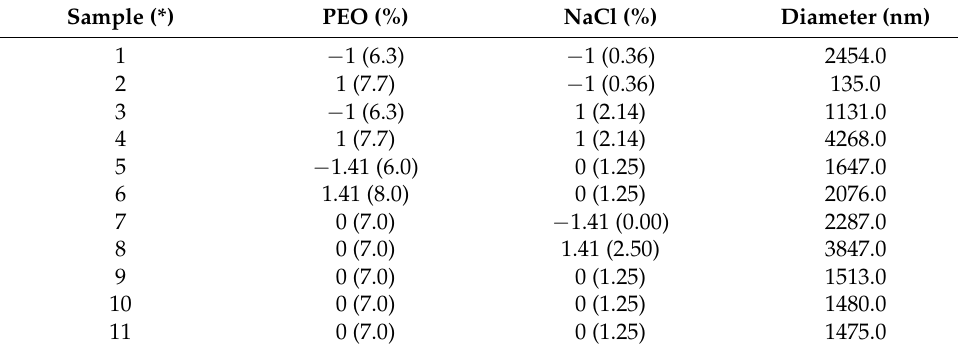
Table 1. Coded and experimental values and the diameter measurements (nm) of core-shell nanofibers with jussara pulp.